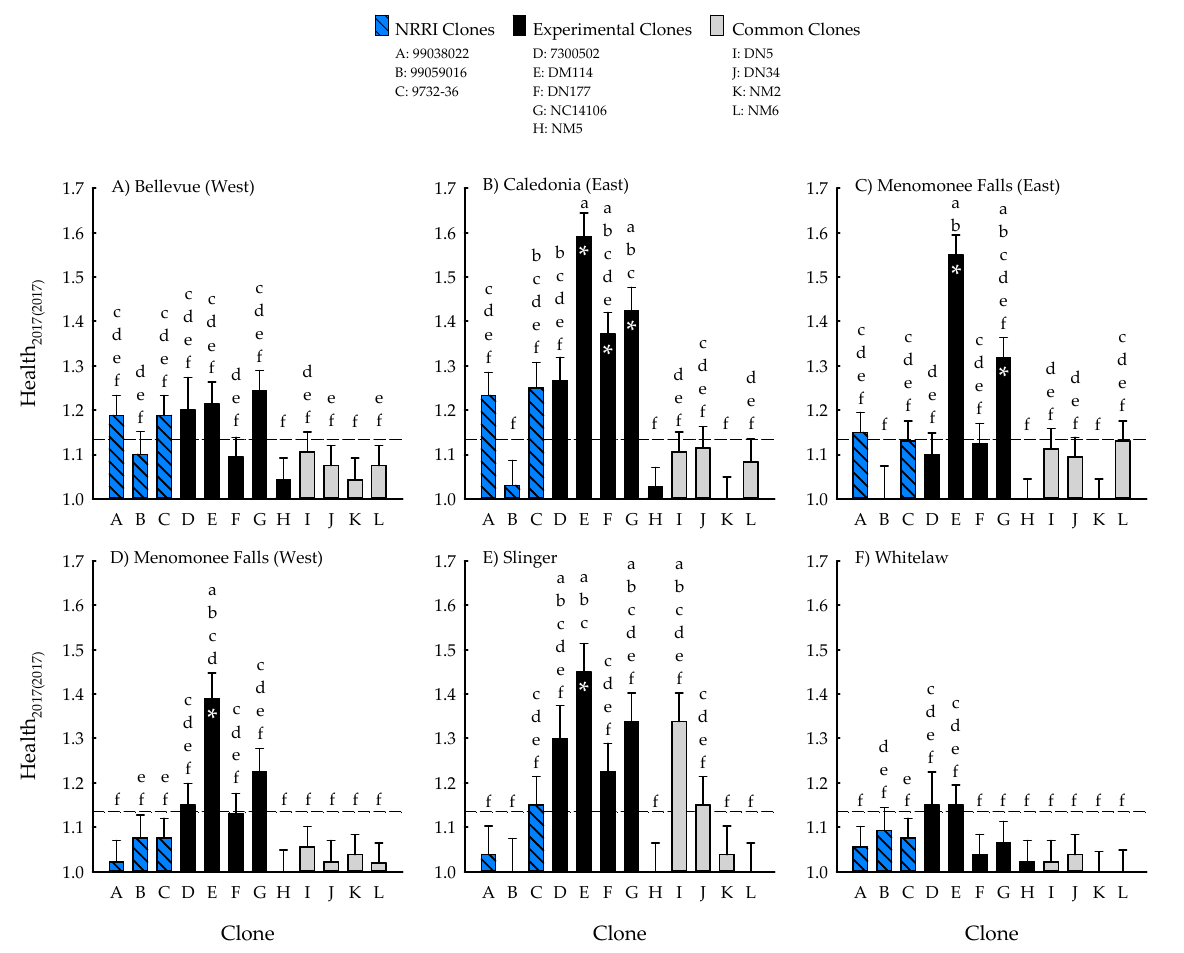
Figure 2. Tree health ( ± one standard error) determined after the 2017 growing season of twelve poplar clones tested in six phytoremediation buffer systems (i.e., phyto buffers) ( A – F ) established in 2017 (i.e., the 2017 buffer group) in the Lake Michigan watershed of eastern Wisconsin, USA. The dashed line represents the overall mean, and asterisks indicate means different than the overall mean at P < 0.05. Bars with different letters across all buffer × clone combinations are different at P < 0.05. See Materials and Methods for complete tree health definitions (1 = optimal health, 2 = good health, 3 = moderate health, 4 = poor health, and 5 =